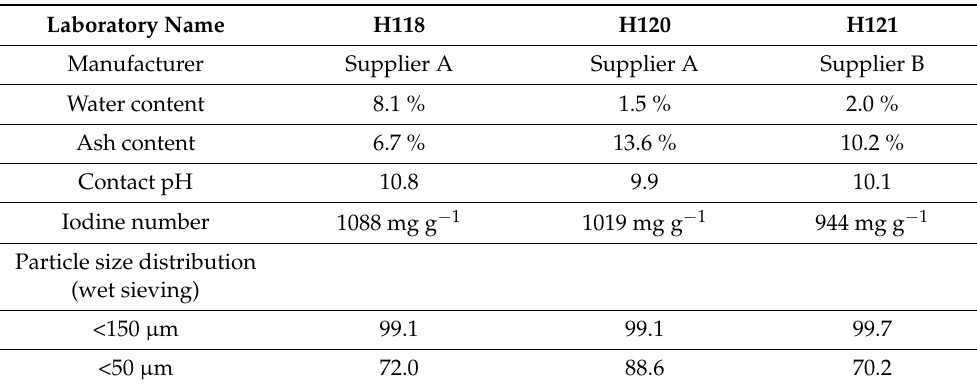
Table 3. The types of powdered activated carbon (PAC) used for the batch sorption experiments. Values were partially published before